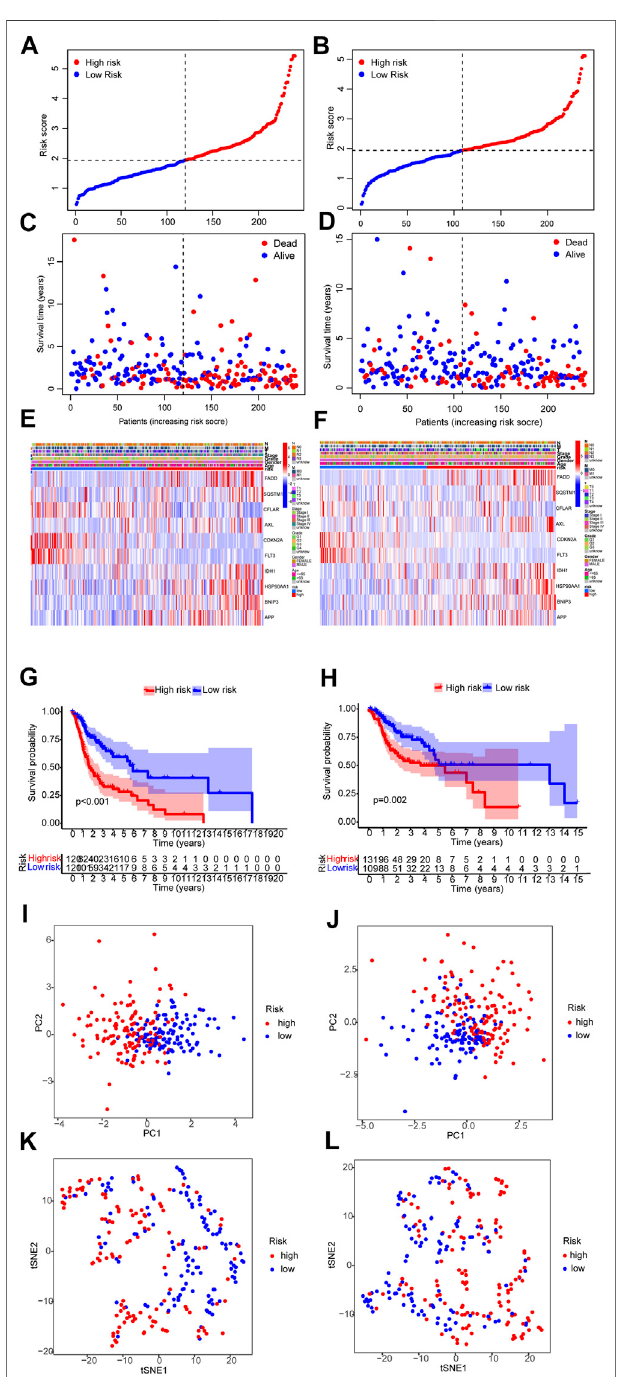
FIGURE 5 | Prognosis assay in the training and validation sets. (A,B) Risk scoreof the training and validation sets. (C,D) Survivalcomparison ofthe low-risk and the high-risk groups in the training and validation sets. (E,F) The heat map of clinicopathological characteristics and expression of 6 genes. (G,H) Survival curves of the low-risk and the high-risk groups in the training and validation sets. (I – L) PCA and T-NSE plots of the low-risk and the high-risk groups of the training and validation